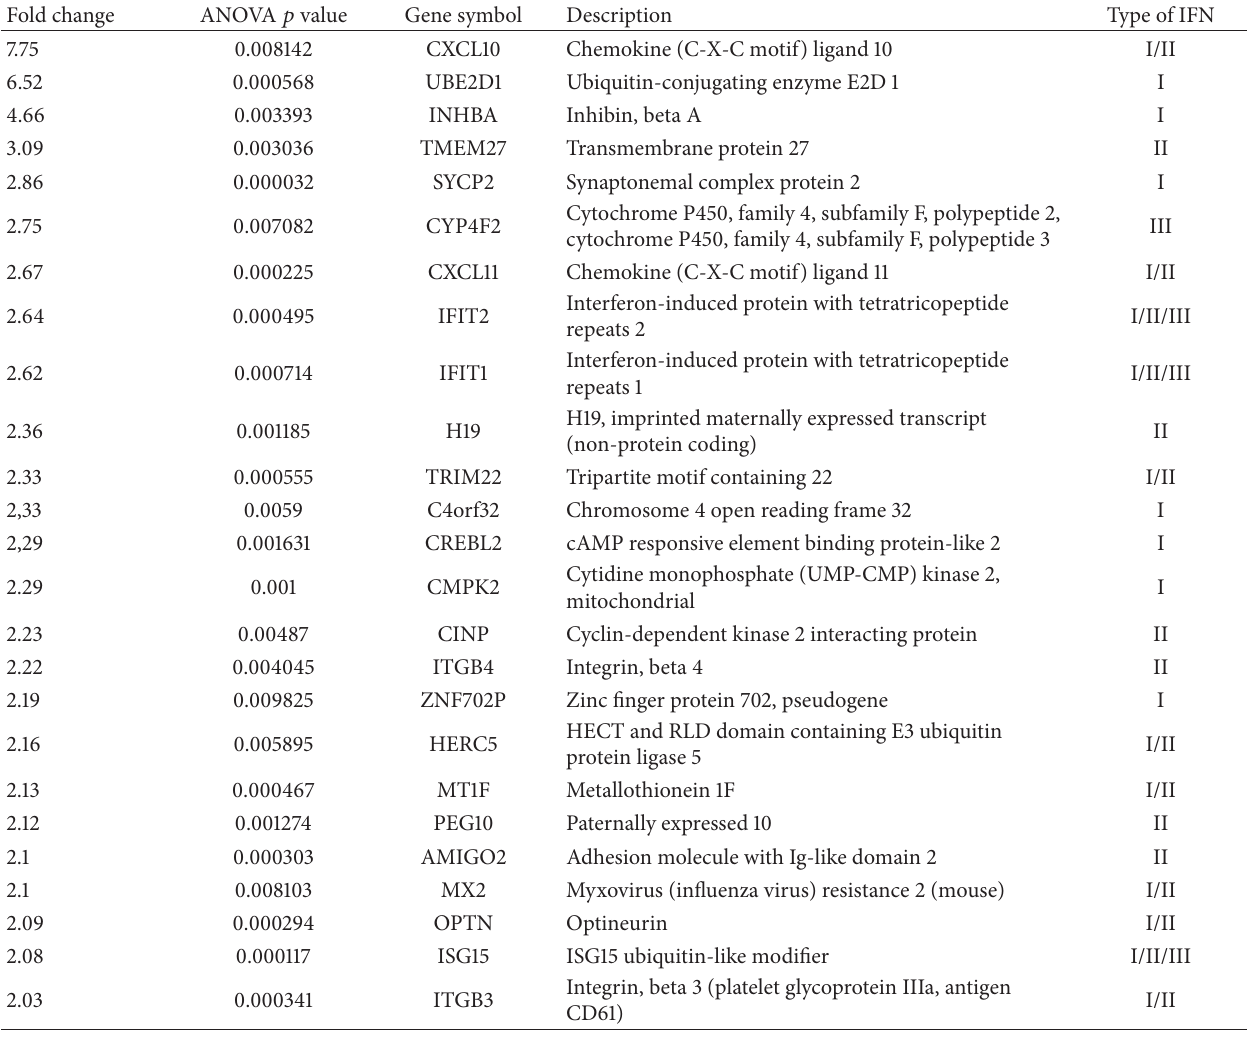
Table 2: List of known ISGs which depend for their full activation by IFN 𝛼 on ZNF395, identified in RTS3b keratinocytes by microarray. Fold